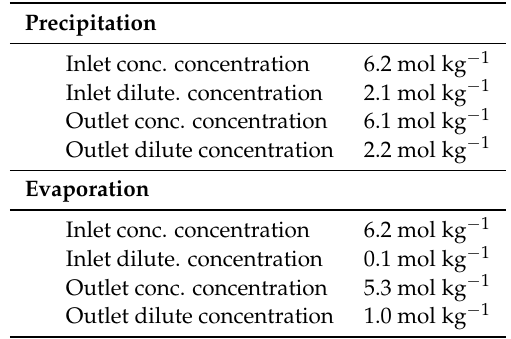
Table 9. Inlet and outlet concentrations for the dilute and concentrated